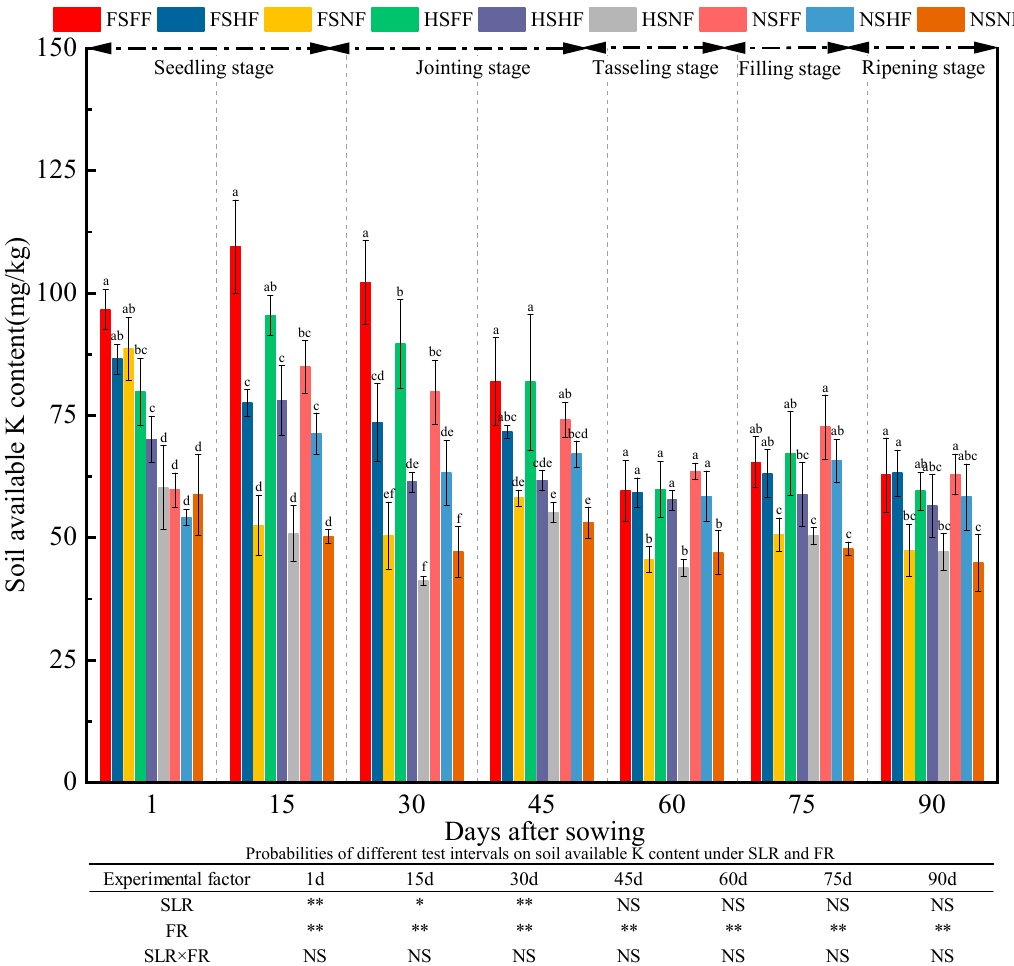
Figure 12. Effects of SLR and FR on the soil AK content. Note: Bars represent means ± standard deviation ( n = 3) with different letters indicating significant differences based on LSD ( p ≤ 0.05). SLR, sugarcane leaf return; FR, fertilizer reduction.